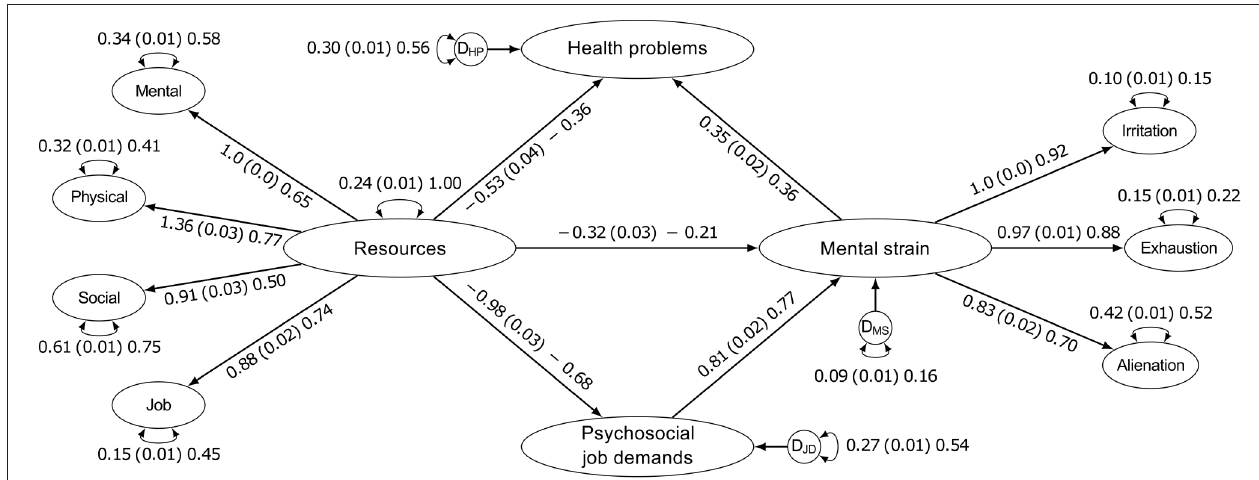
FIGURE 2 | Results of the final model. We report the estimates as “unstandardized (standard error) standardized.” D JD , D MS , and D HP stand for the disturbance variances of the respective endogenous variables. All reported coefficients and factor loadings were significant (all p s < 0.001). Due to the high number of observed variables used in this research (45 items in total), we only reported the latent variable model. Model fit of the final model was good: χ 2 (915) = 17833.77; CFI = 0.966; TLI = 0.964; RMSEA = 0.044, 90% CI [0.043, 0.045].